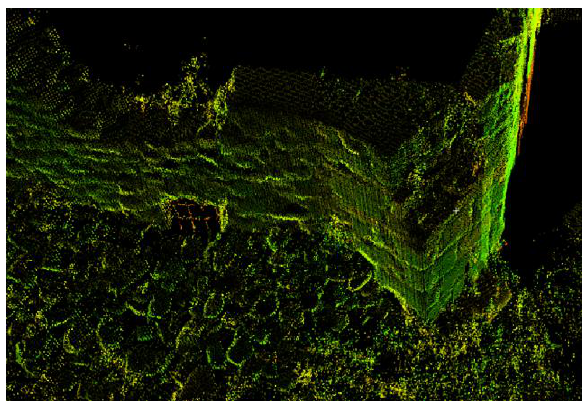
Figure 4. The view of TLS data of part of castle ruins